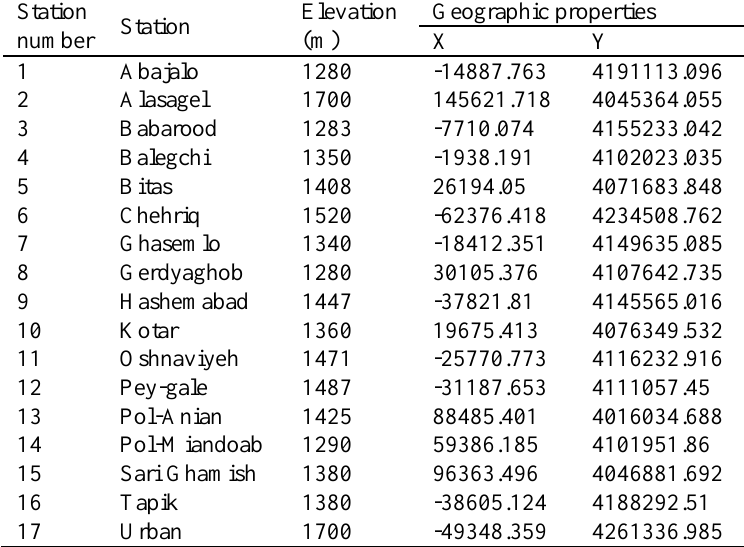
Table 1. Specifications of hydrometric stations used in this